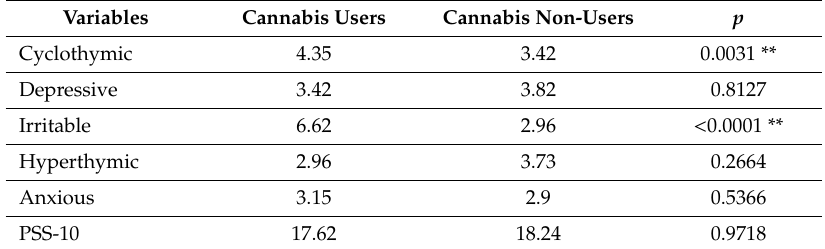
Table 2. Between-groups di ff erences among cannabis users and non-users in mean score of the perceived stress scale 10 (PSS-10) and the five domains of the Memphis, Pisa, Paris and San Diego Auto-Questionnaire (TEMPS-A) scale.